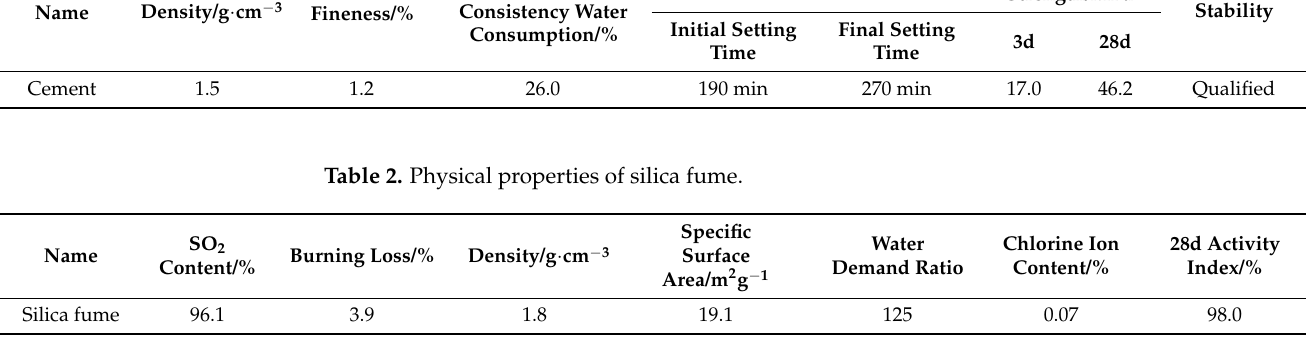
Table 1. Physical properties of cement.